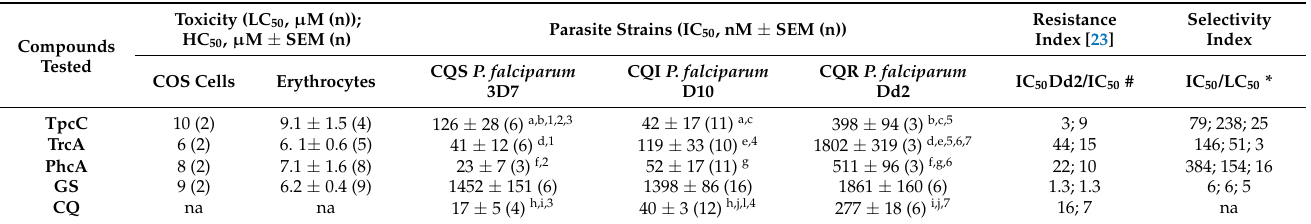
Table 1. Differences in susceptibility of three strains of P. falciparum to Trc analogues with GS as reference peptide. All IC 50 values are the means of multiple the biological repeats (n) each conducted with triplicate of quadruplicate technical repeats. The resistance index is given as a ratio of activity against CQ resistant strain Dd2 versus CQ sensitive strains, 3D7 and D10. Subscript letters indicate statistically significant differences (Student t -test) between activity against different P. falciparum strains for each compound. Subscript letters indicate statistically significant differences (One-way Anova with Bonferroni post-test) between activity of different compounds (excluding GS) against a specific strain of P. falciparum